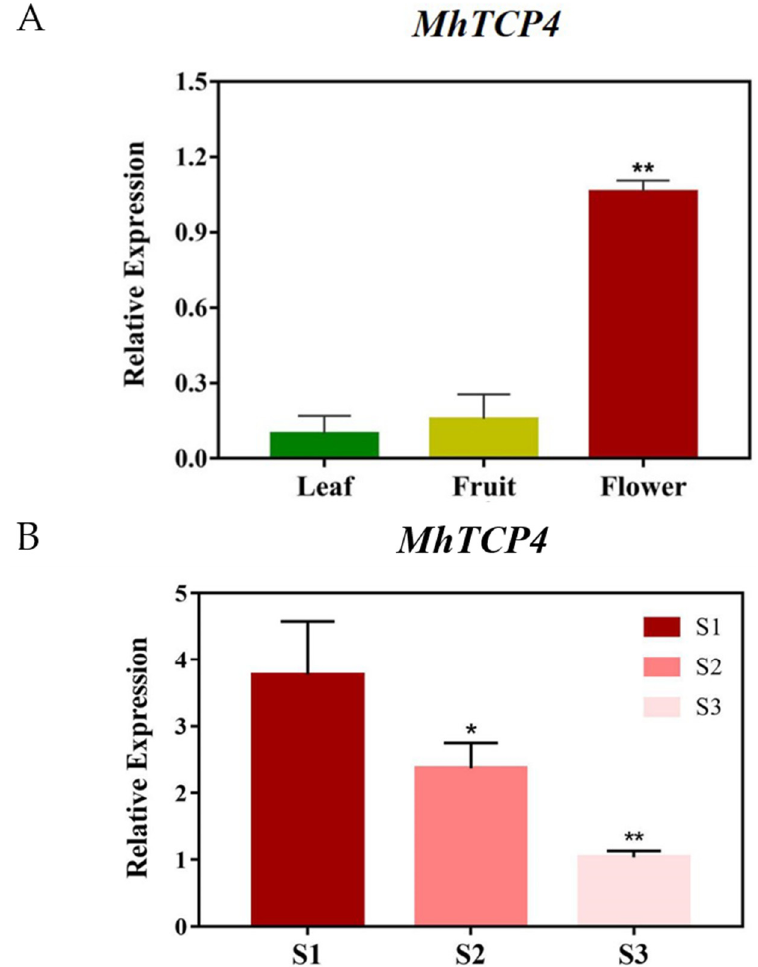
Figure 4. MhTCP4 tissue specific expression analysis and spatio-temporal differential expression analysis in petals of Malus halliana. ( A ) The tissue-specific expression of MhTCP4 was analyzed. The left y -axis denotes the RNA relative expression obtained by qRT-PCR. ( B ) Spatio-temporal differential expression of MhTCP4 in the petals of Malus halliana . S1, S2 and S3 represent the three different stages of the petals of Malus halliana . Error bars represent the SEs of three biological replicates and three technical replicates. * p < 0.05, ** p < 0.01 using the t -test.